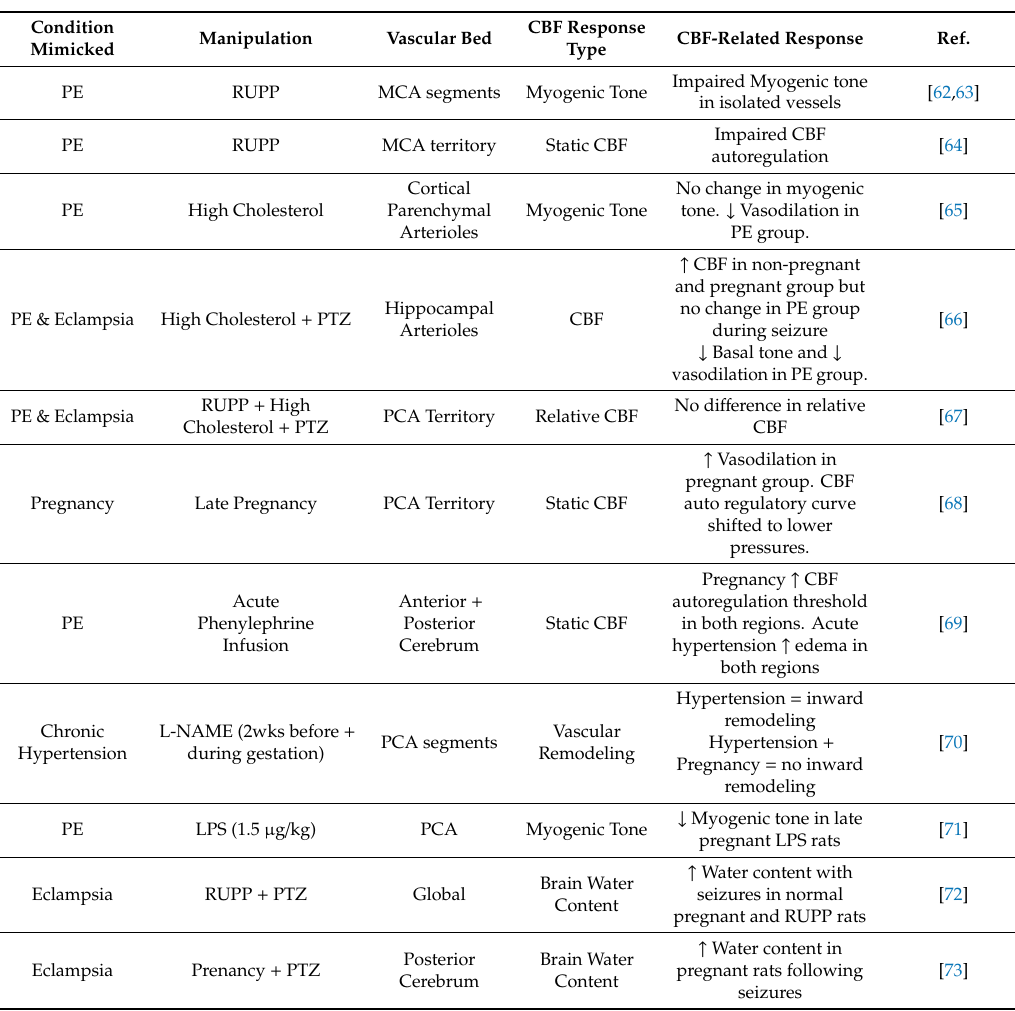
Table 2. Summary of animal studies describing the impact of pregnancy or pregnancy complicated by hypertension on